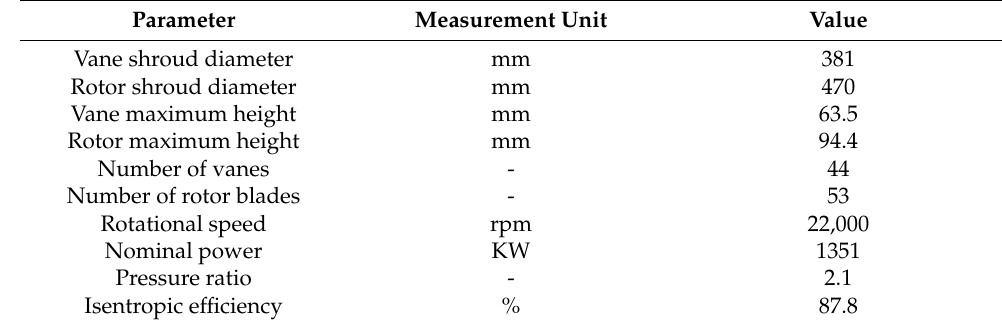
Table 1. Reference turbine main